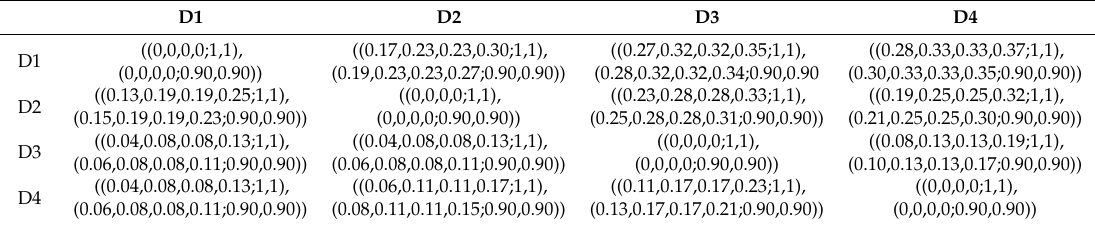
Table 5. Normalized direct-relation matrix for the dimensions.